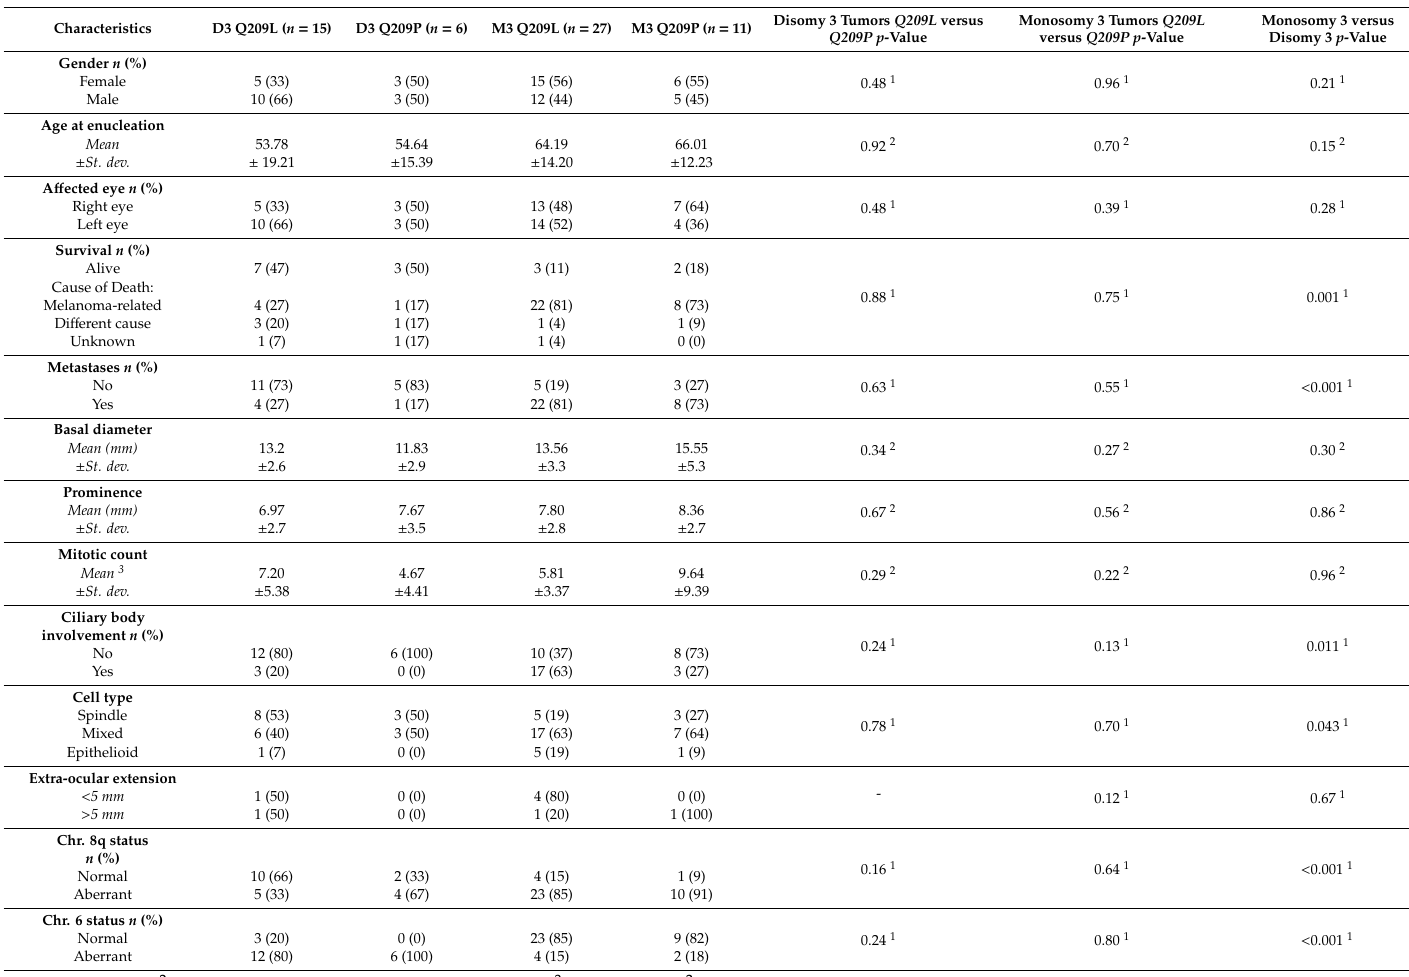
Table 2. Comparison of 59 patients for whom HLA expression (mRNA), chromosome 3 status, and type of GNAQ / GNA11 mutation was known. Significant values are shown in bold. The categorical groups were compared using a chi-squared test and numerical data was compared using an independent t -test.